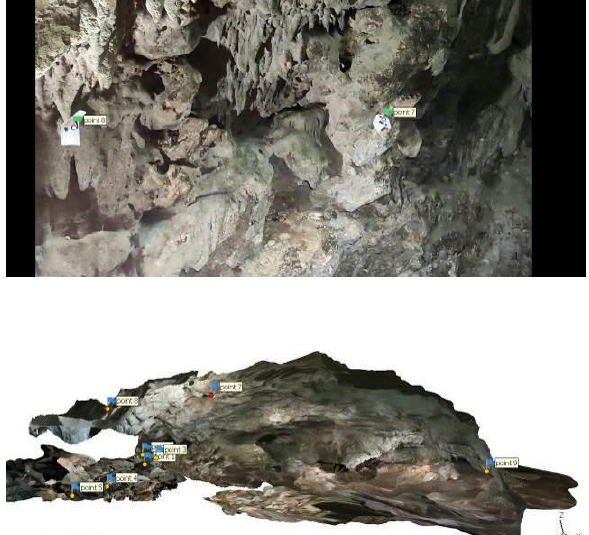
Figure 5 – The common markers on one image (top) and the point cloud (bottom)